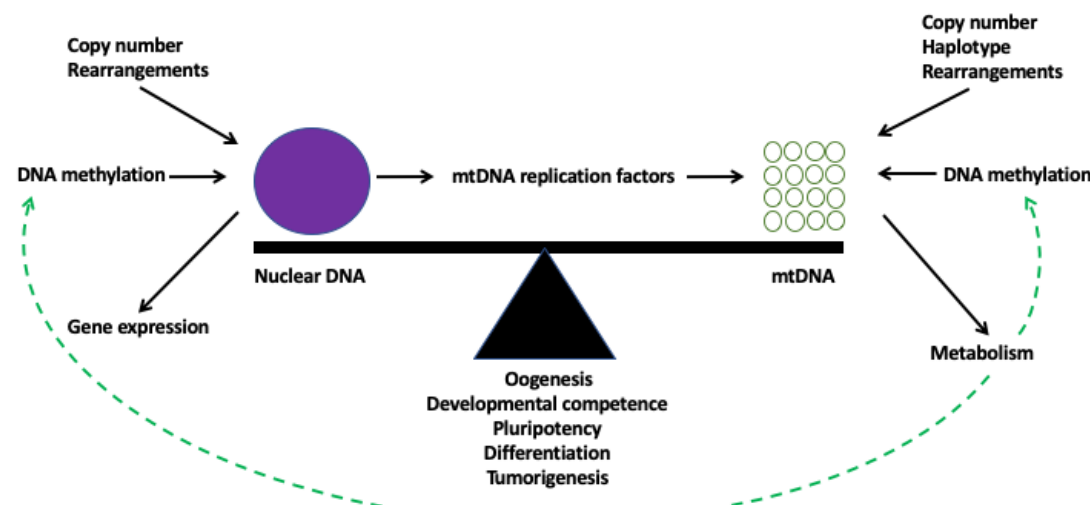
Figure 3. Model of genomic balance. At any given stage in development, for a cell to be ultimately functional, it needs to establish genomic balance. There is a continual flow of regulatory information between the nucleus and the mitochondrial genome that ensures there are su ffi cient copies of mtDNA to meet a cell’s functional requirements for ATP through OXPHOS. At the level of the nuclear genome, genomic balance is mediated by epigenetic changes, for example the levels of DNA methylation, which control gene expression. Other factors include DNA rearrangements, such as mutations and deletions, and copy number variants. At the level of the mitochondrial genome, the choice of cellular metabolism will a ff ect mtDNA copy number, which, in turn, is aided by the cell’s mtDNA genotype. As a result, metabolic factors are released which can modulate DNA methylation and other epigenetic modifiers that regulate both the nuclear and mitochondrial